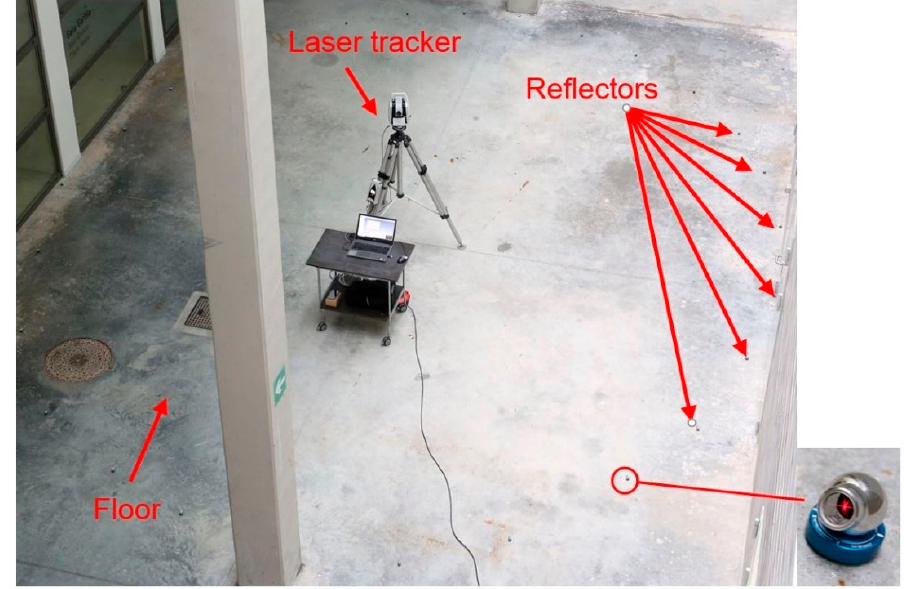
Figure 10. Measurement scenario at IK4-TEKNIKER for simulated results validation.